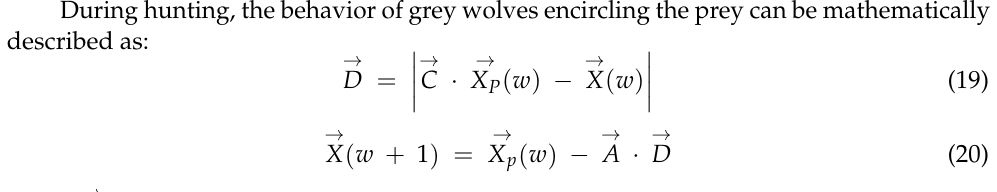
Figure 8. Social dominant hierarchy of grey wolf